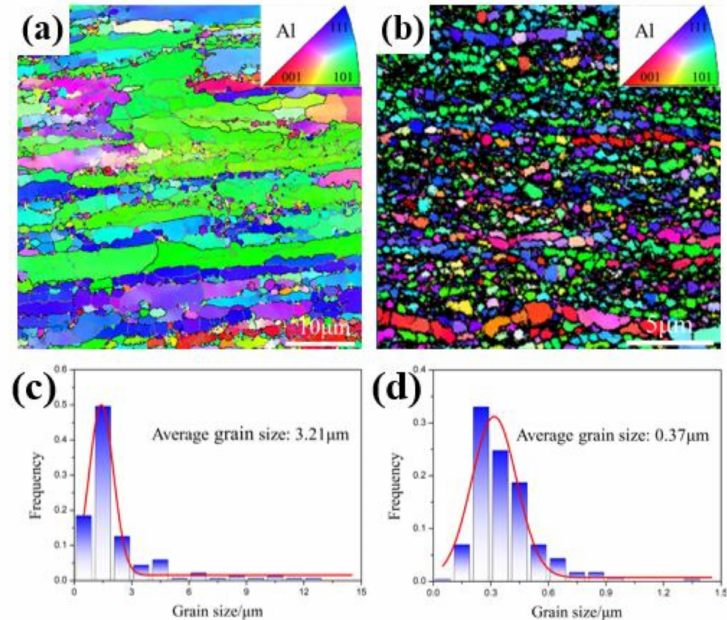
Figure 4. Electron backscattered di ff raction (EBSD) characterization of the AlN / Al nanocomposites along the longitudinal direction before and after rolling treatment: ( a , c ) inverse pole figure (IPF) map of matrix grains of the as-extruded composites and the size distribution of matrix grains; ( b , d ) IPF map of matrix grains of the composite after 85% rolling at 300 ◦ C and the size distribution of matrix